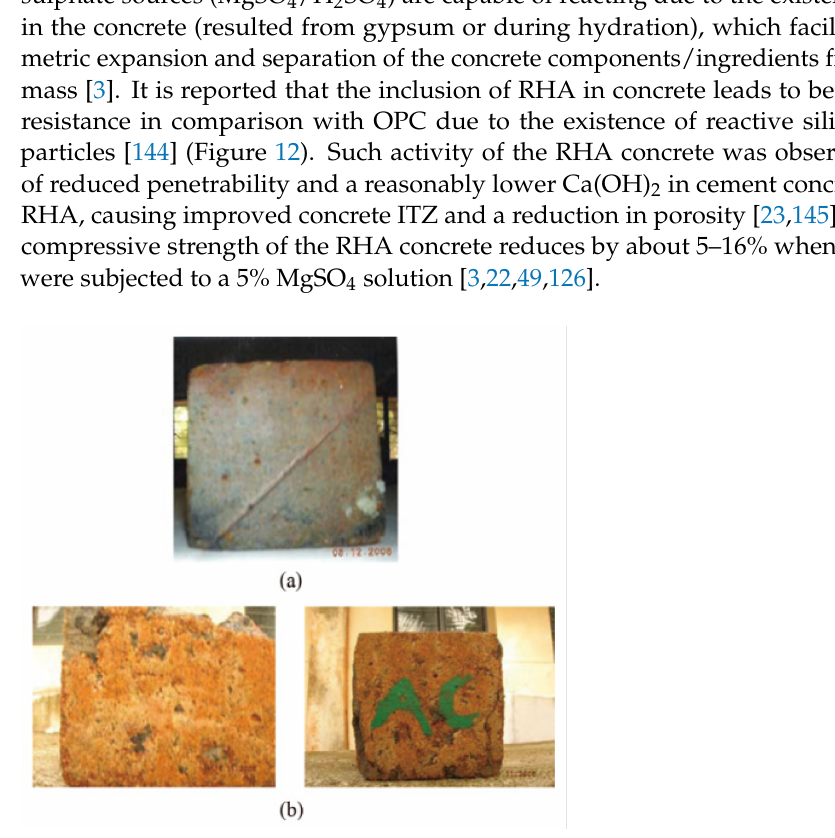
Figure 12. Resistance of ( a ) ordinary concrete and ( b ) RHA-based concrete against acid attack